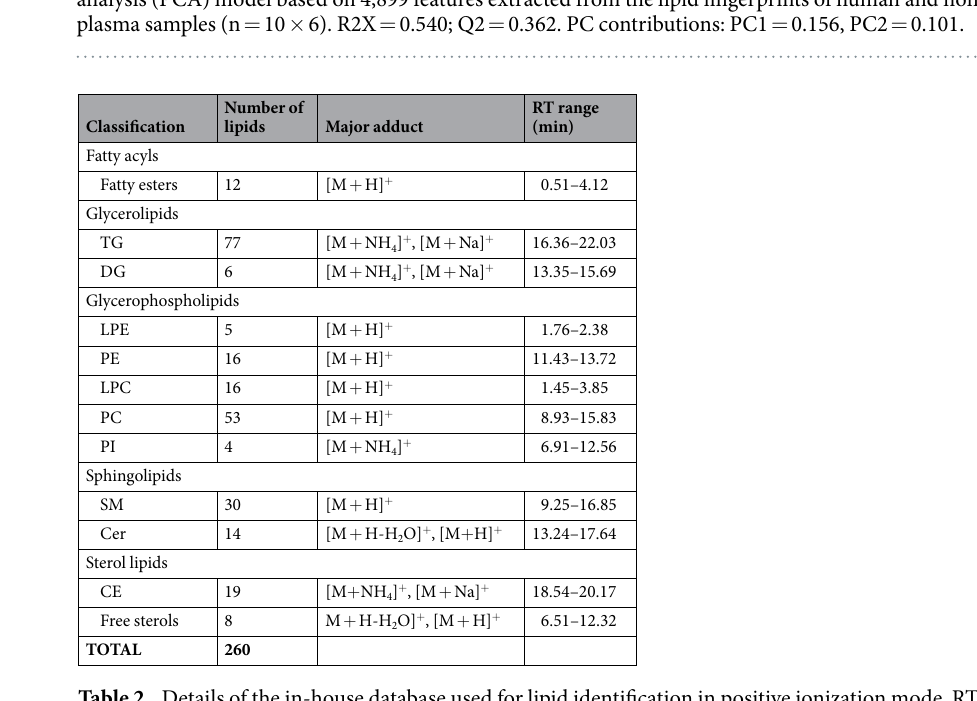
Table 2. Details of the in-house database used for lipid identification in positive ionization mode. RT, retention time; n/a, not applicable; TG, triglyceride; DG, diglyceride; LPE, lysophosphatidylethanolamine;